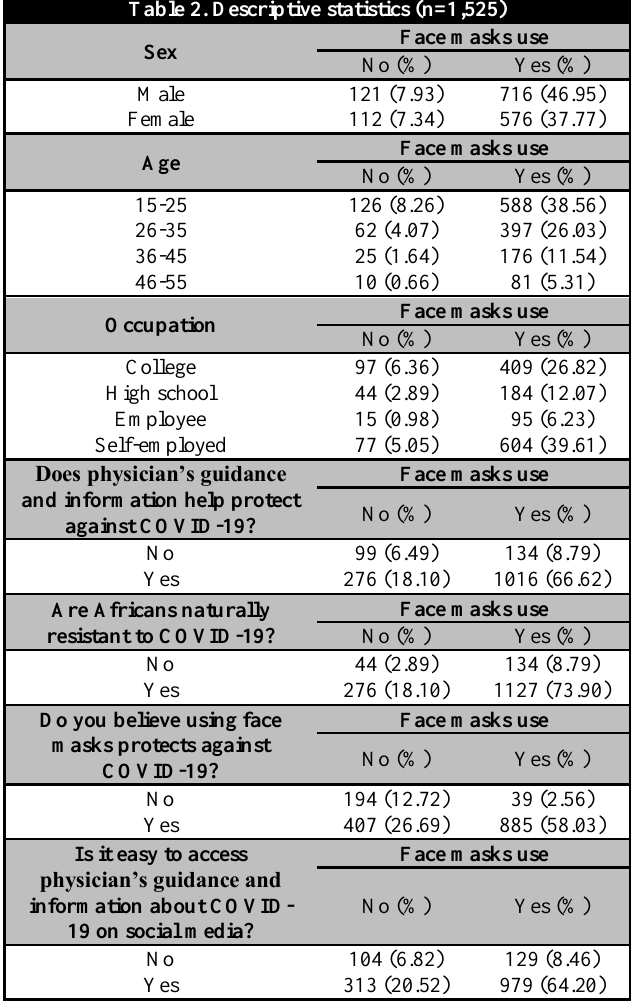
Table 2. Descriptive statistics